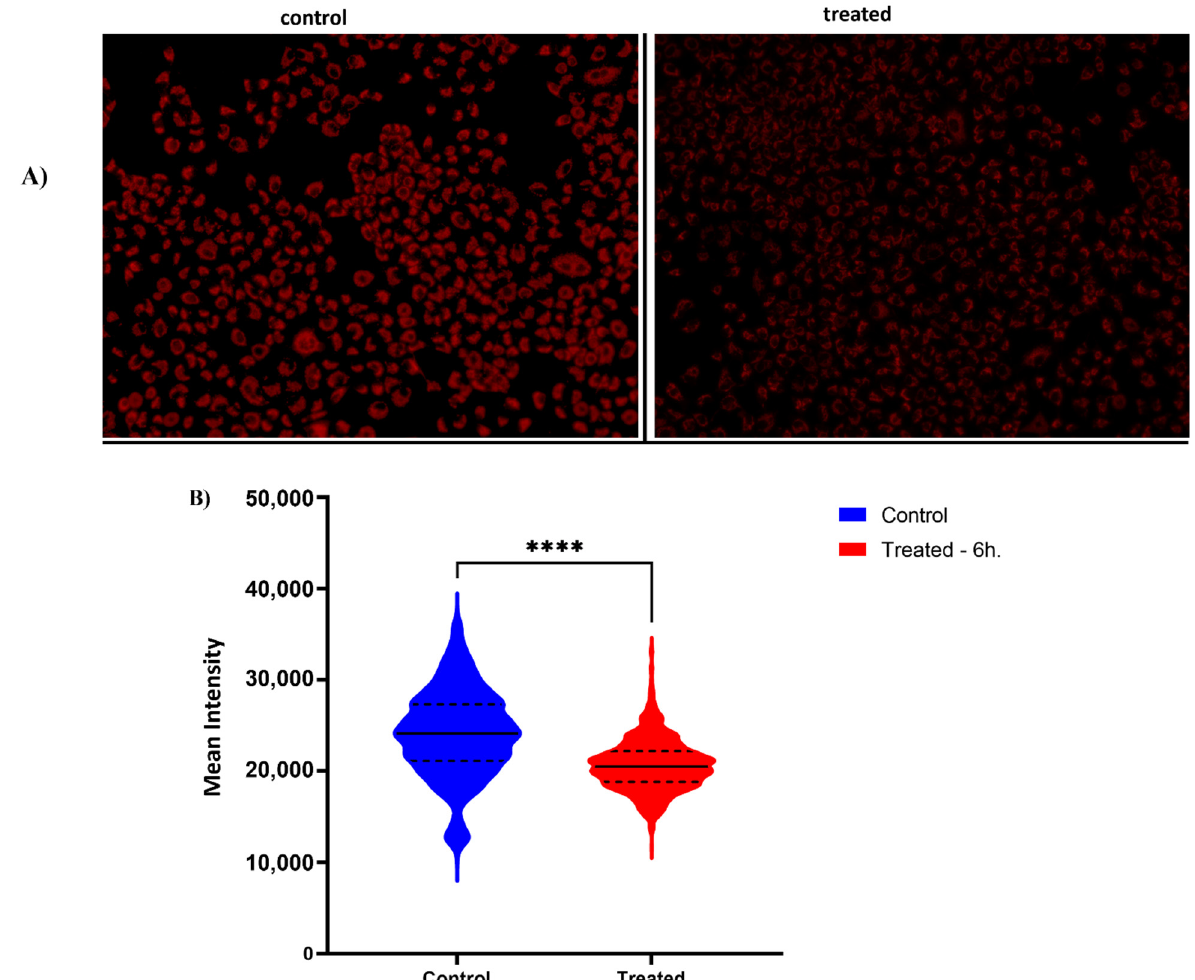
Figure 5. Measurement of mitochondrial content in A549 cells. A549 cells were treated with SSE (200 µg/mL) for 6 h. Fluorescence intensities of Mito-Tracker Red were quantified. Treatment with SSE reduces the number of mitochondria in cells. ( A ). Representative immunofluorescence images. The intensity of the fluorescent dye in each cell represents the amount of mitochondrial mass. Lower intensity of fluorescence MitoRed dye in treated cells compared to untreated cells demonstrates reduced mitochondria content ( B ). Violin plot demonstrates the difference in mitochondrial content between untreated (blue) and treated (red) samples. On the Y -axis Mean Intensity of the mitochondrial mass of the cells has been shown. Low intensity indicates fewer mitochondria inside the cells. ****, p < 0.001.